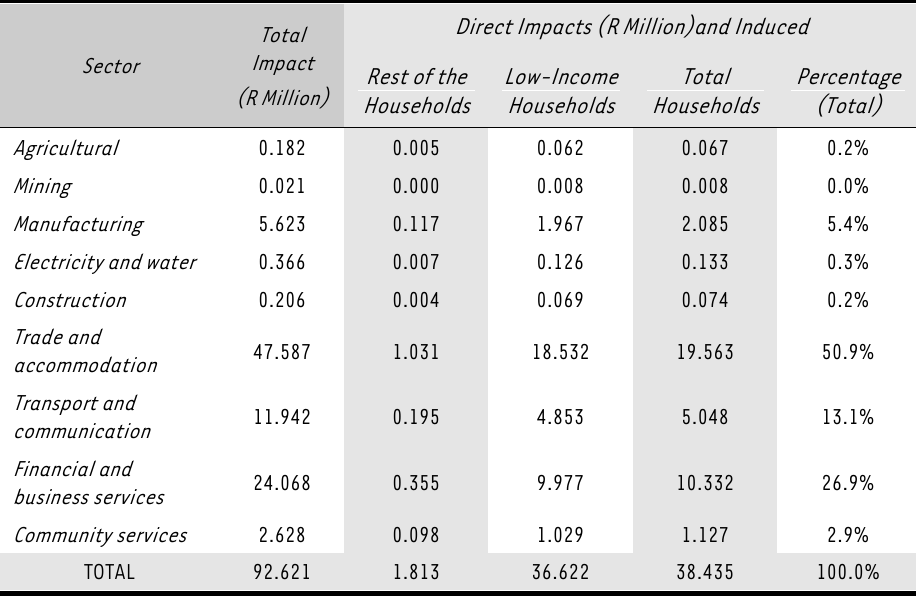
The impact of the KKNK on family